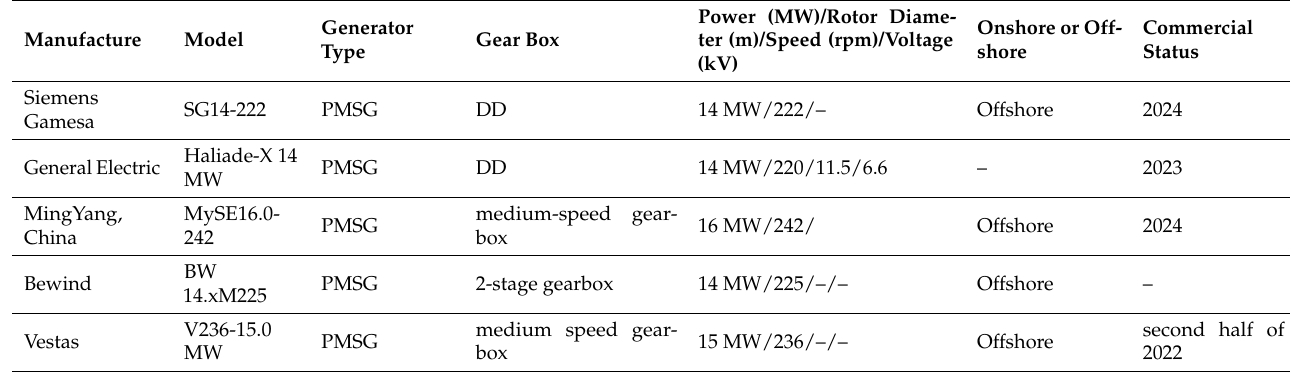
Table 4. High power WT generators under development